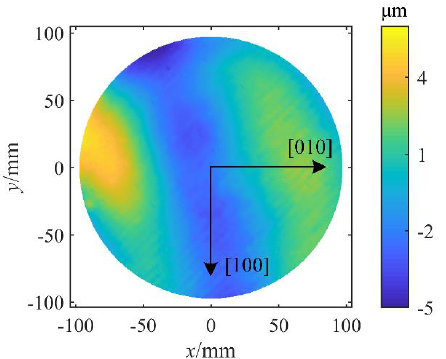
Figure 1. Measured surface deformation of a double-sided polished silicon